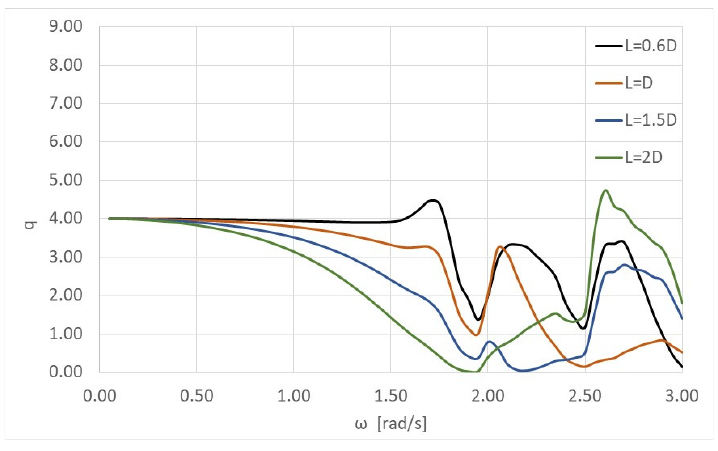
Figure 12. The q factor term of the parallel to the wall WEC array, against ω , for 0° wave heading angle and for distances L = 0.6D, D, 1.5D, and